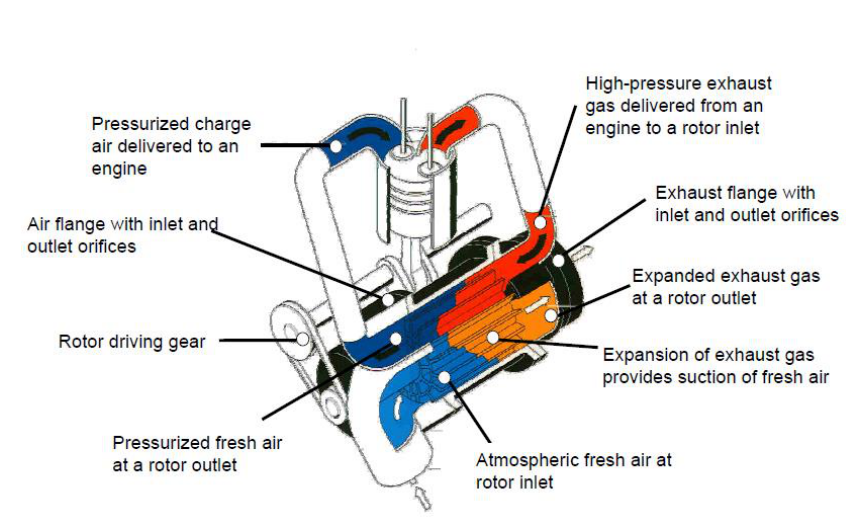
Figure 3. Engine fitted with pressure wave